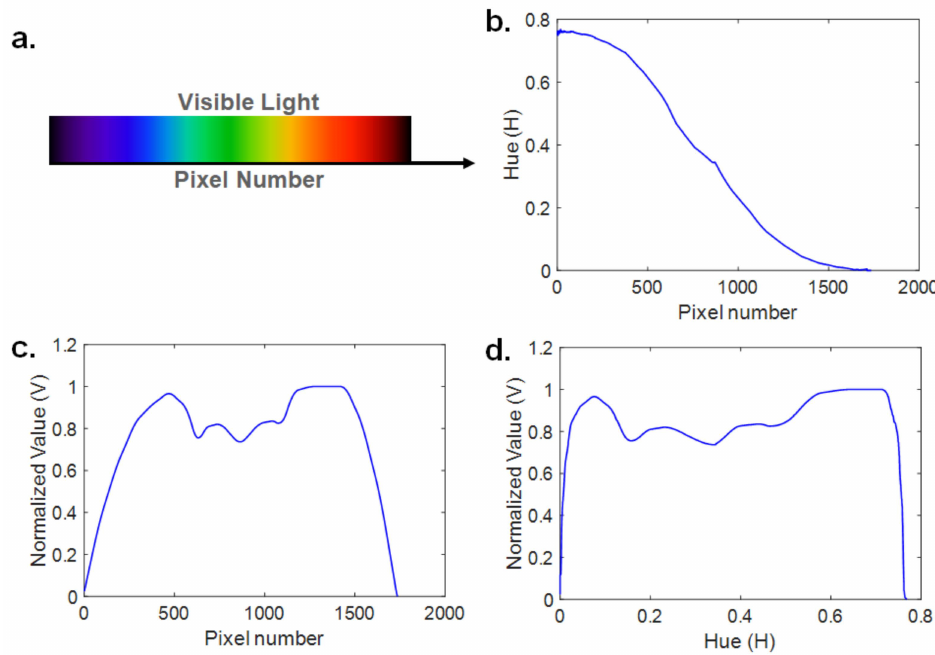
Figure 7. Simulation results from the spectral image of visible light [33]: ( a ) visible spectral image, ( b ) H vs. pixel number, ( c ) normalized value ( V ) vs. pixel number, and ( d ) spectrum curve ( V vs. H